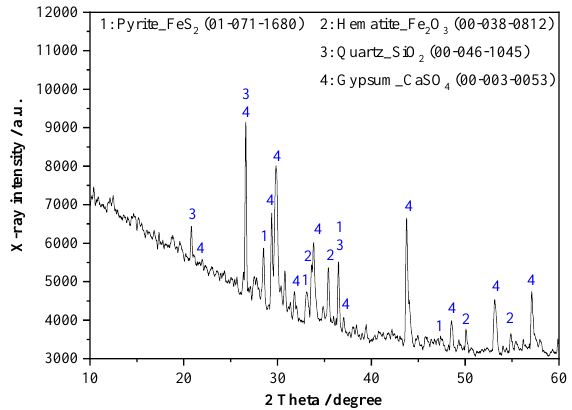
Figure 3. Chemical characteristics of STs obtained using XRD.